Question: Give a one-sentence summary of this figure.
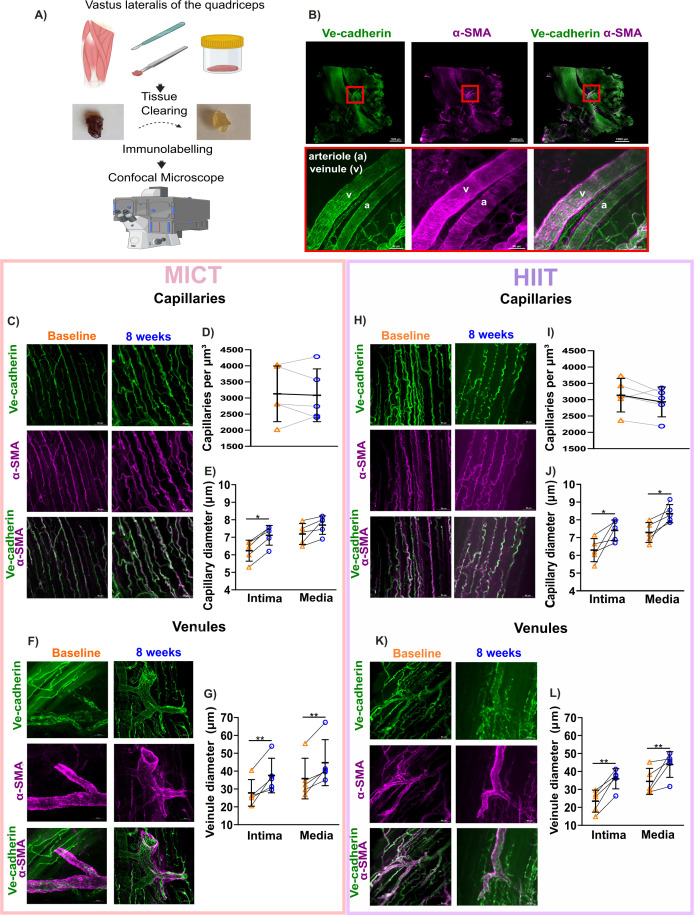
Answer: This figure presents the methodological workflow for muscle biopsy processing and image acquisition, as well as the vascular remodeling observed in response to exercise training. (A) Schematic overview of the biopsy protocol performed in 10 participants. Samples were collected under local anesthesia from the vastus lateralis using a scalpel, then cleared and immunolabeled with VE-cadherin to visualize endothelial cells and withd α-smooth muscle actin (α-SMA) to identify smooth muscle cells and pericytes. Image acquisition was performed using a Nikon AX R confocal microscope. (B) Overview of an entire muscle sample (scale bar: 1000 µm; objective: Apo 10×), with the red box indicating the region of interest. This region contains a venule and an arteriole, distinguishable by their structural features: venules exhibit a loose endothelial architecture with disorganized smooth muscle coverage, whereas arterioles display tightly arranged endothelial cells and concentric smooth muscle rings (scale bar: 50 µm; objective: Apo 20×). (C–G) correspond to the MICT group and (H–L) to the HIIT group. (C, H) represent the visualization of the capillary network before and after 8 weeks of training while (F, K) represent the visualization of a venule before and after 8 weeks of training (scale bar: 50 µm; objective: Apo 20×). (D , I) is the quantification of capillary network, both group didn’t succeed to increased the number of capillaries after training. (E, J) quantify capillary diameter changes at baseline and 8 weeks after training, measured at the intima (VE-cadherin) and media (α-SMA) levels. Both groups exhibited significant dilation of the capillary intimal diameter following training; however, only the HIIT group (J) demonstrated a concomitant increase in pericyte coverage. (G, L) demonstrate venular remodeling in both groups, with increased intima diameter and enhanced smooth muscle cell coverage. Orange triangles represent baseline data; blue circles indicate post-training